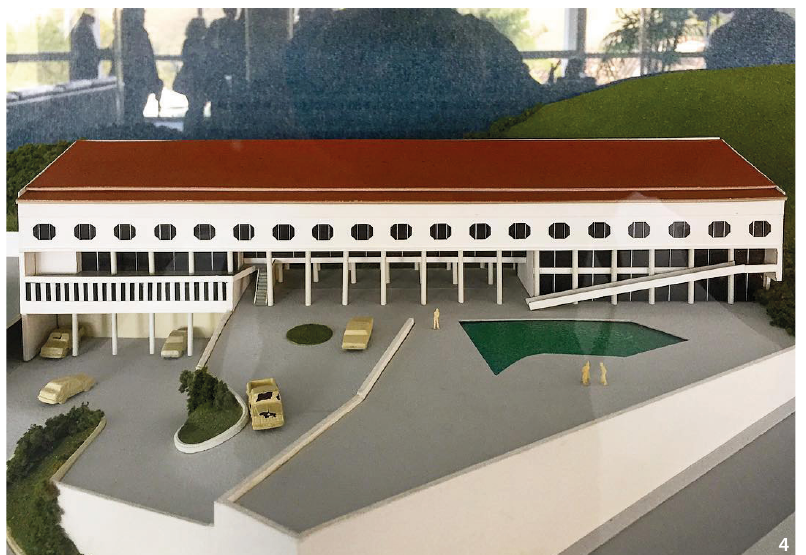
Figure 4 Oscar Niemeyer, Ouro Preto Grand Hotel, model of 1993 reform proposal (Source: Rodrigo Queiroz).